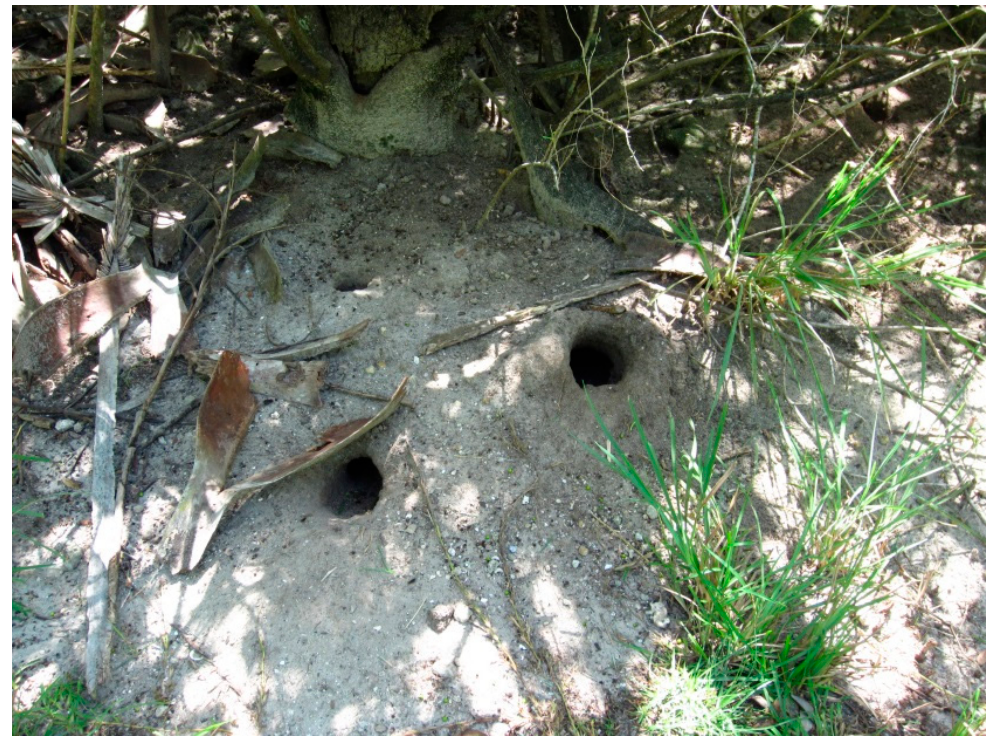
Figure 3. Entrances to three blue land crab burrows in a south Florida salt marsh. The interior of these burrows serves as the major reproductive habitat for the mosquito Deinocerites cancer .